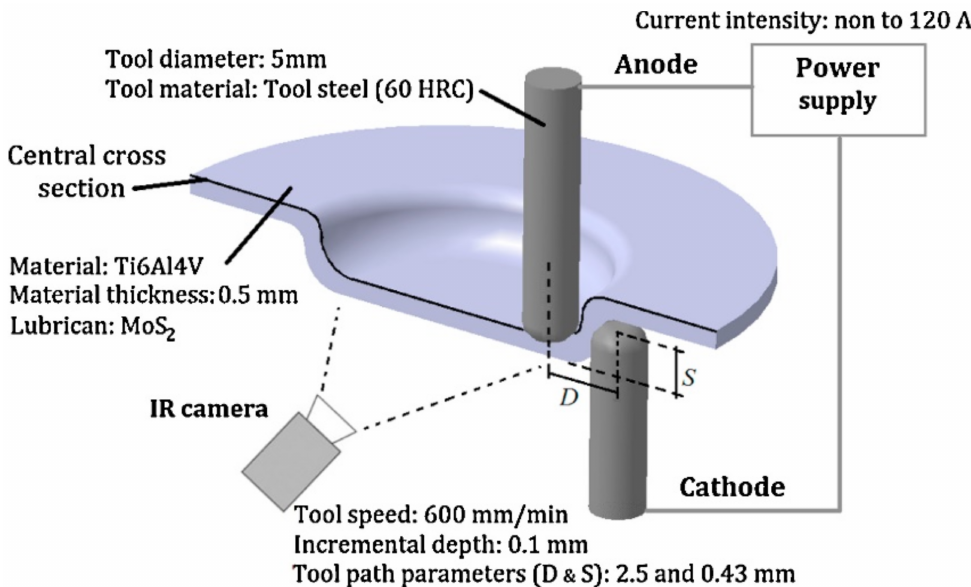
Figure 18. The experimental layout used to study the differences between electrically-assisted cumulative double-sided incremental forming (E-ADSIF) and electrically-assisted mixed double- sided incremental forming (E-MDSIF) (reproduced with permission from [115]; copyright © 2016 College International pour la Recherche en